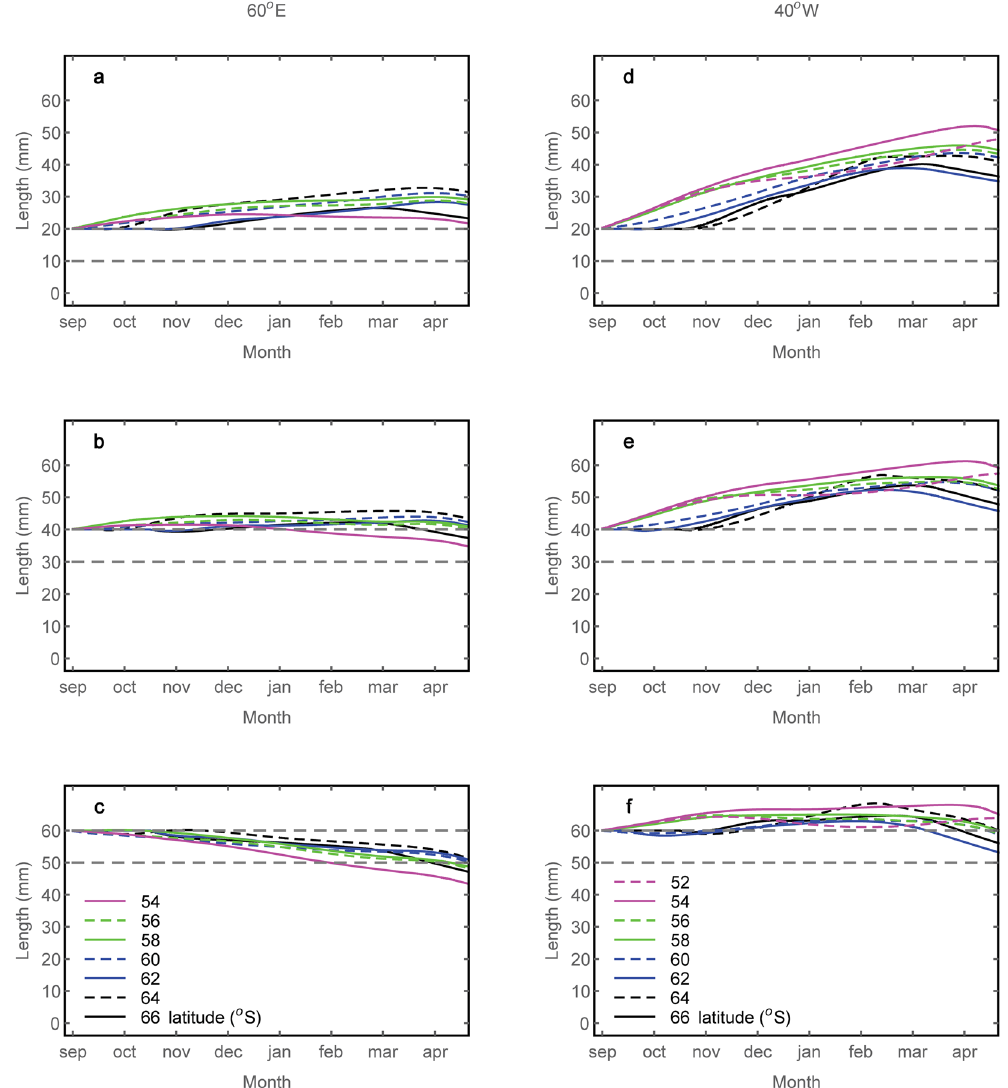
Figure 4. Growth curves at different latitudes along two longitudes from September to mid-April: 60°E (Indian Ocean sector, left panels ( a–c )) and 40°W (Scotia/Weddell Seas, right panels, ( d–f ). Initial sizes of 20 mm ( a , d ), 40 mm ( b , e ) and 60 mm ( c , f ) and dashed lines show initial size and initial size minus 10 mm. Colours indicate latitude. Figure created using Wolfram Mathematica version 11